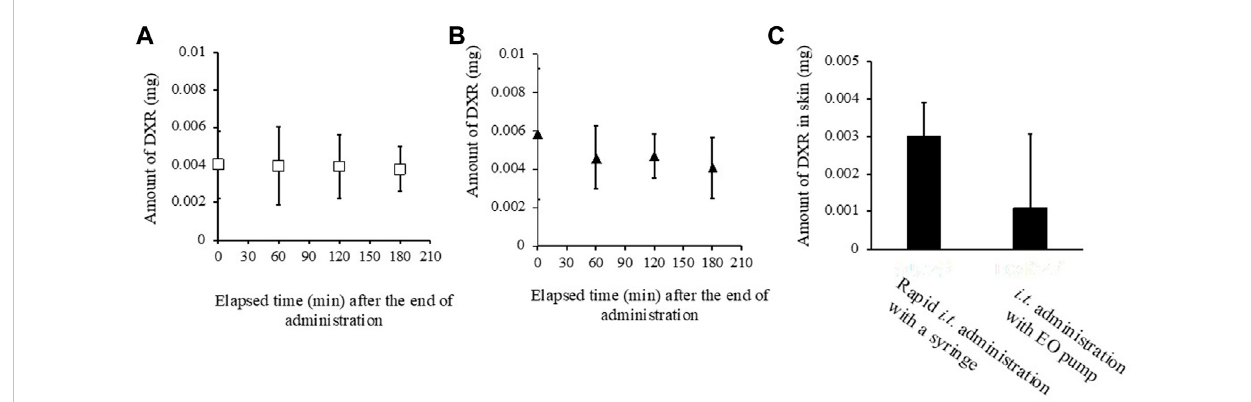
FIGURE 6 AmountofDXRintumor (A,B) ,itsperipheralskinaroundthetumorsite (C) . (A) rapid i.t. administrationofDXRwithasyringeatadoseof20 μ g, (B)